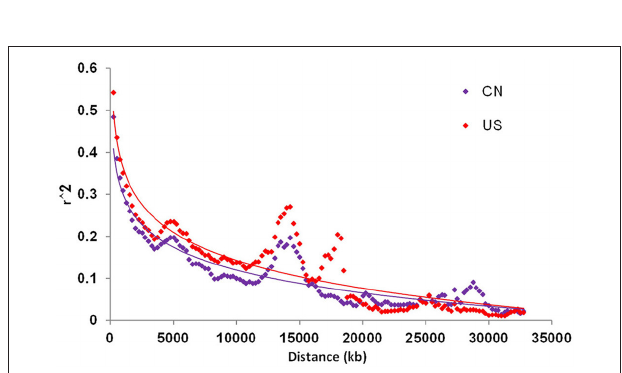
FIGURE 3 | Linkage disequilibrium (LD) decay of China and US soybean accessions. CN is for China; and US is for United States of